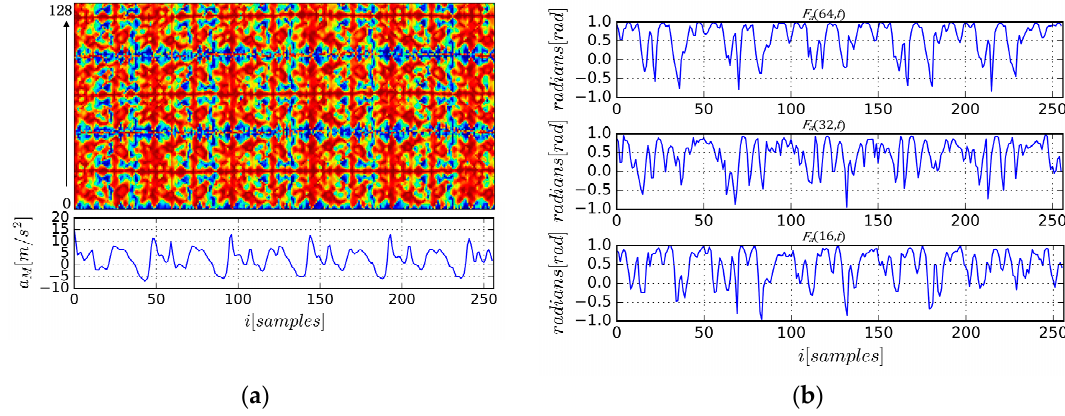
Figure 4. Demonstration for AE-GDI generated from the acceleration components time series, where N w = 256, N h = 128; ( a ) AE-GDI and its corresponding acceleration magnitude sequence with the time axis aligned; ( b ) examples for angle time series F a ( m , t ) extracted from AE-GDI in ( a ) with m = 16,32,64 respectively.